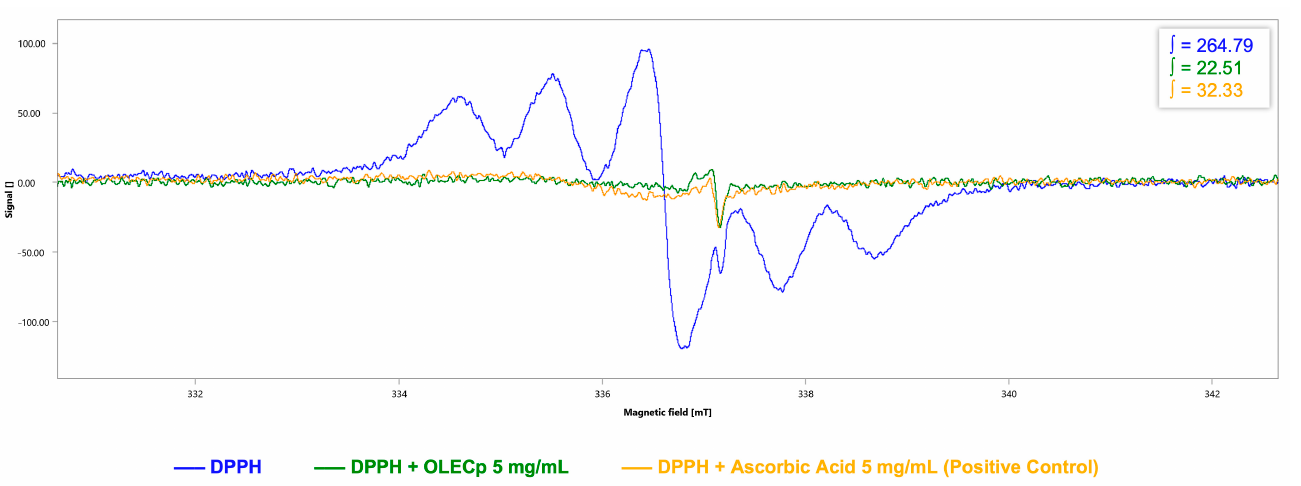
Figure 6. DPPH-EPR assay. EPR spectra and respective signal areas ( ∫ ) of DPPH in the absence (blue) and presence of OLECp (green) or ascorbic acid as positive control (yellow).